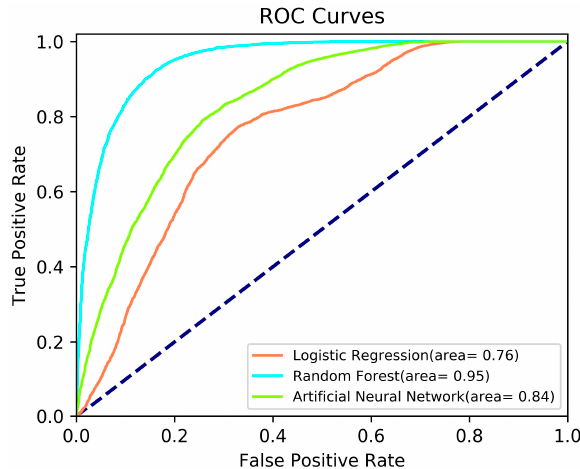
Figure 9. ROC curves obtained from the classifications with LR, ANN, and RF.